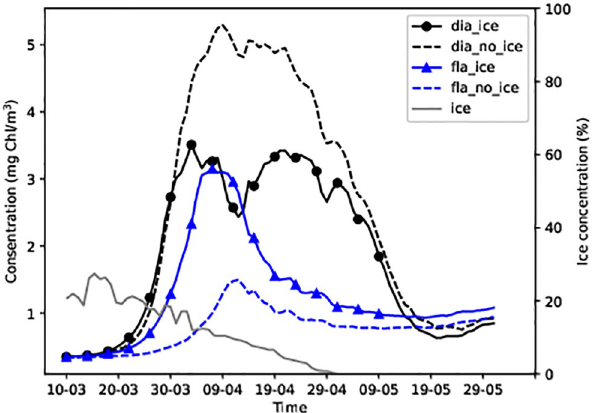
Fig 2. Average diatom and dinoflagellate concentrations over the central Baltic Sea in spring 2013 in the biggest area (Fig 1) over which sea ice was present during the season. Continuous lines represent the results of simulations with sea ice whereas broken lines represent the results of simulations without sea